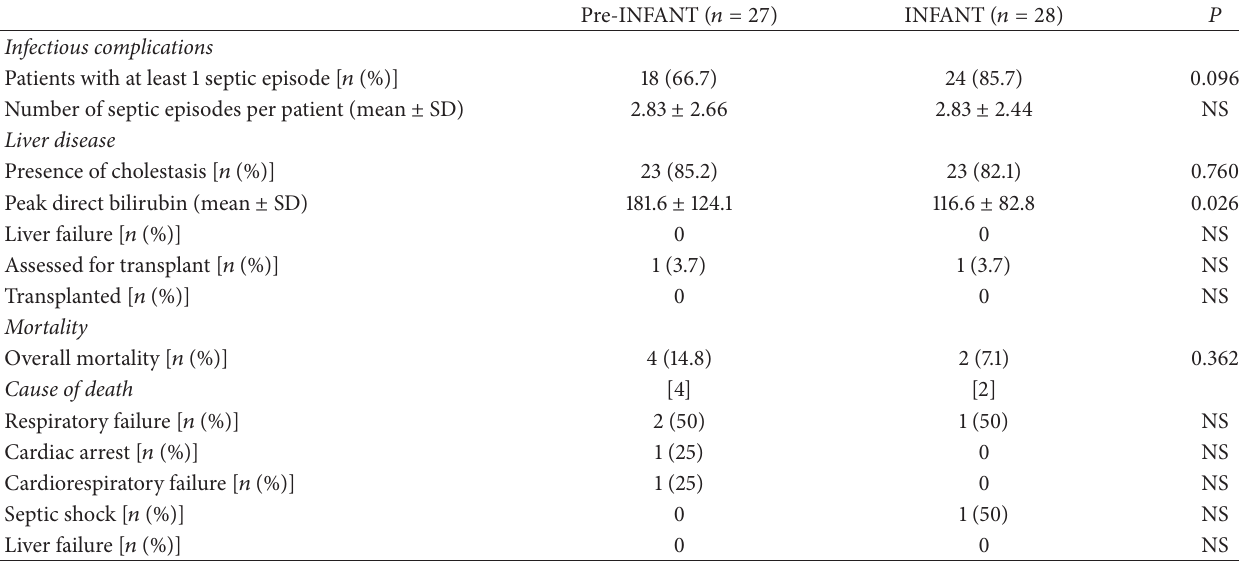
Table 3: Morbidity and mortality of infants with